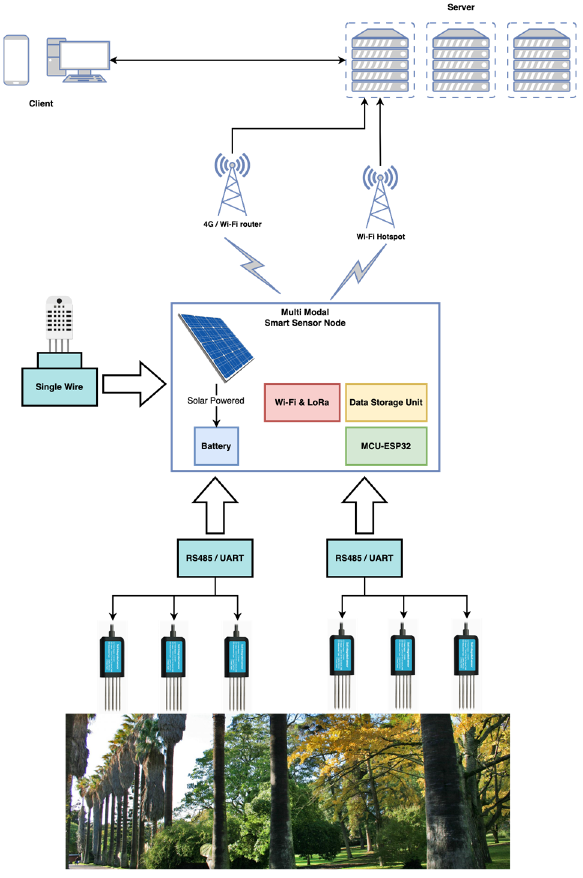
Figure 3. IoT ecosystem architecture for plant stress assessment for Tropical Botanical Garden of Lisbon.